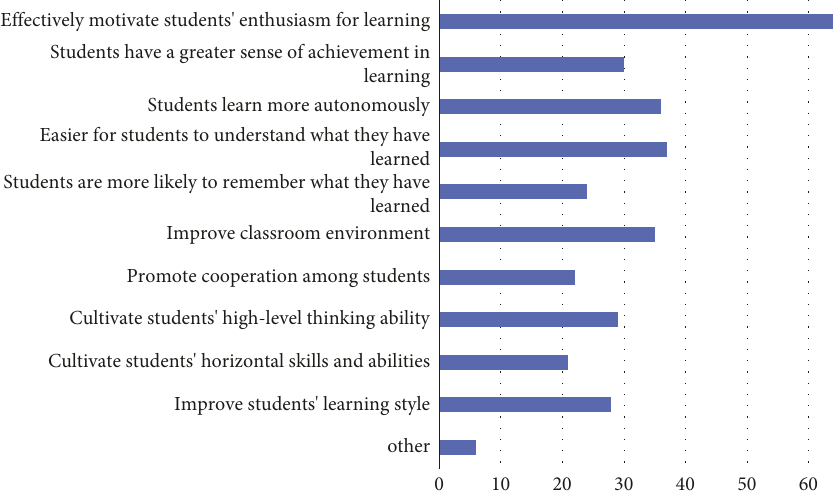
Figure 8: Survey of teachers’ perceptions of positive impact of using information technology.